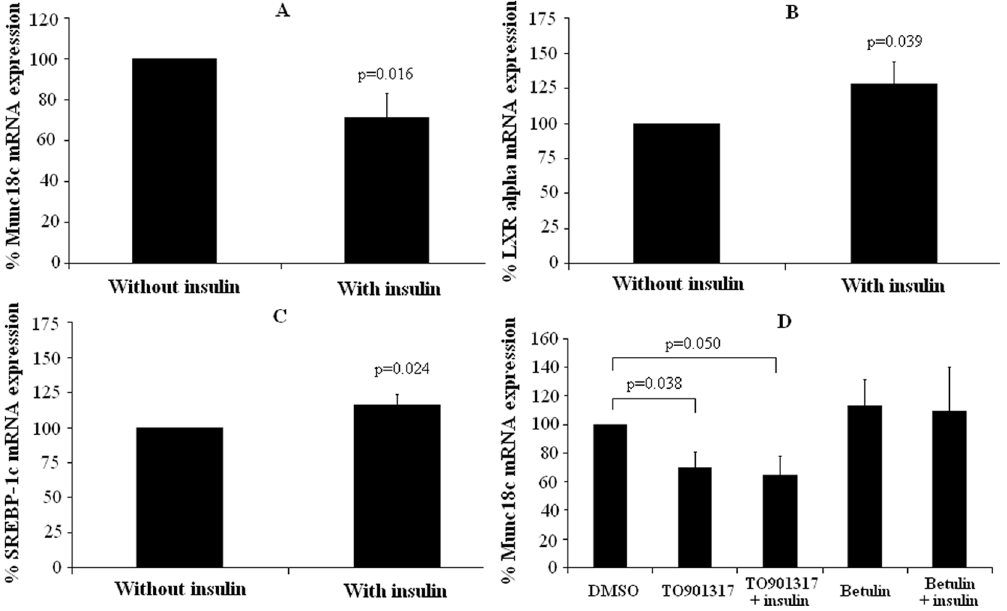
Figure 2. Gene expression in subcutaneous adipose tissue (SAT) explants (n=4) incubated with different compounds. (A) Munc18c gene expression in SAT explants incubated without or with insulin (1000 nM). (B) Liver X receptor-alpha (LXR a ) gene expression in SAT explants incubated without or with insulin (1000 nM). (C) Sterol regulatory element-binding protein-1c (SREBP-1c) gene expression in SAT explants incubated without or with insulin (1000 nM). (D) Munc18c gene expression in SAT explants incubated in the presence of LXR a agonist (T0901317) (10 m M) and SREBP-1c inhibitor (Betulin) (6 m g/ml), in the presence or absence of insulin (1000 nM). DMSO: Dimethyl sulfoxide. The results are given as the mean 6 SEM.